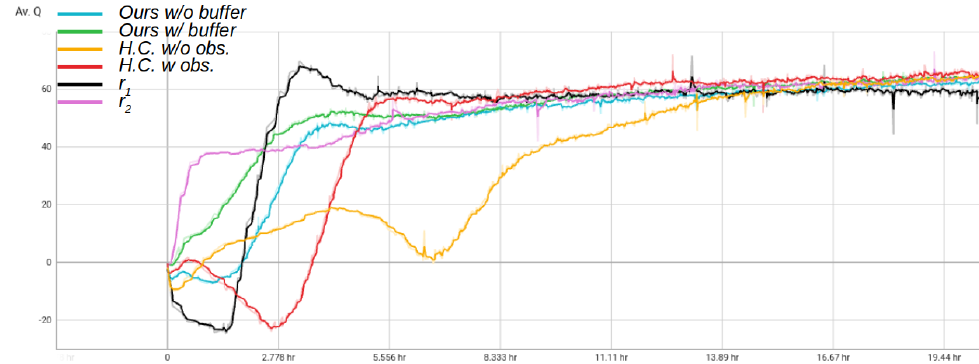
Figure 7. A training time representation of average Q value seen per each training for each policy. The training time was executed for approximately 20 h for each